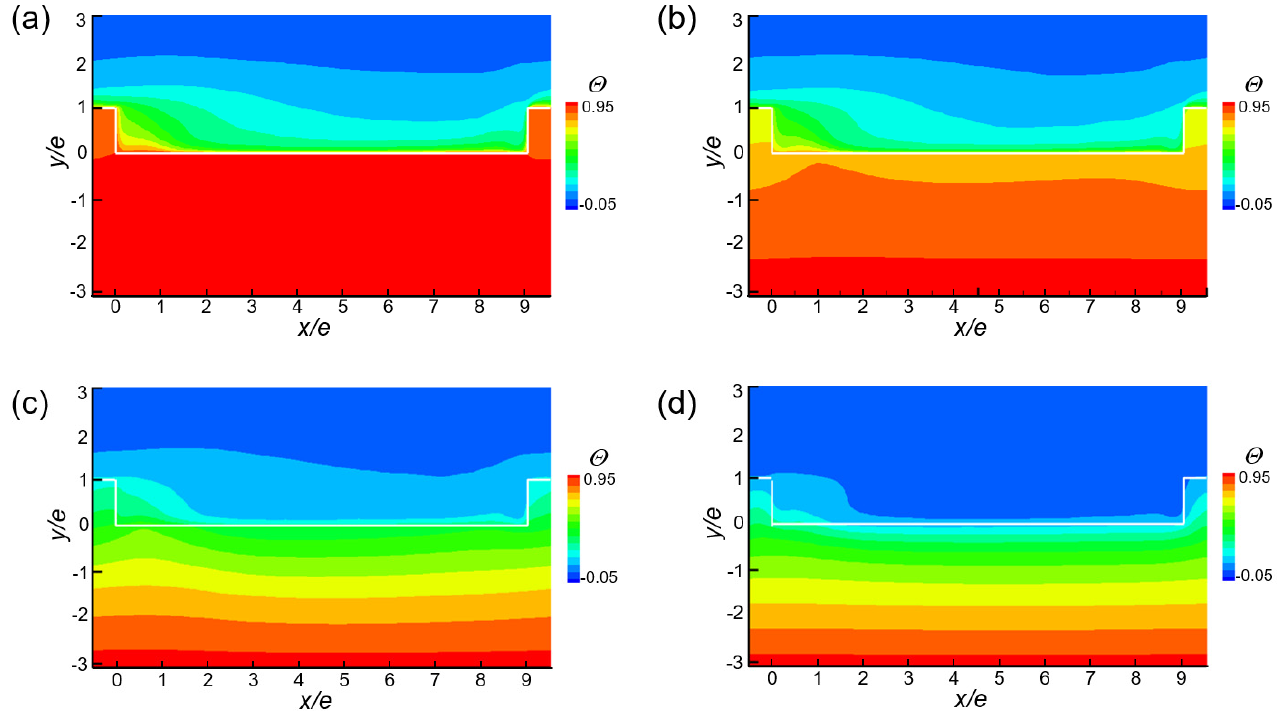
Figure 3. Time-averaged thermal fields: ( a ) K* = 566.26, ( b ) K* = 100.00, ( c ) K* = 10.00, and ( d ) K* = 1.00.